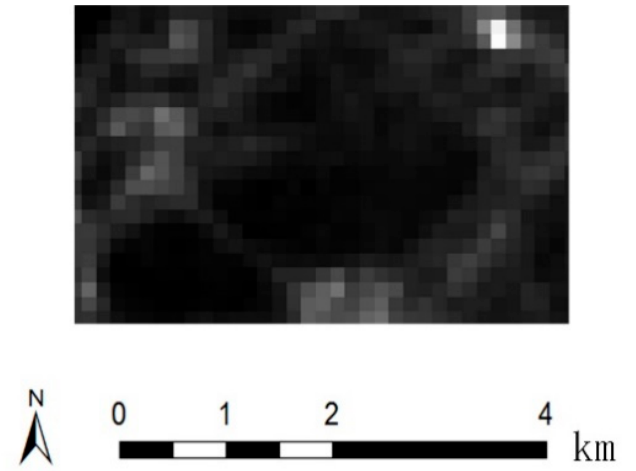
Figure 5. A sample of the Luojia1-01 data.